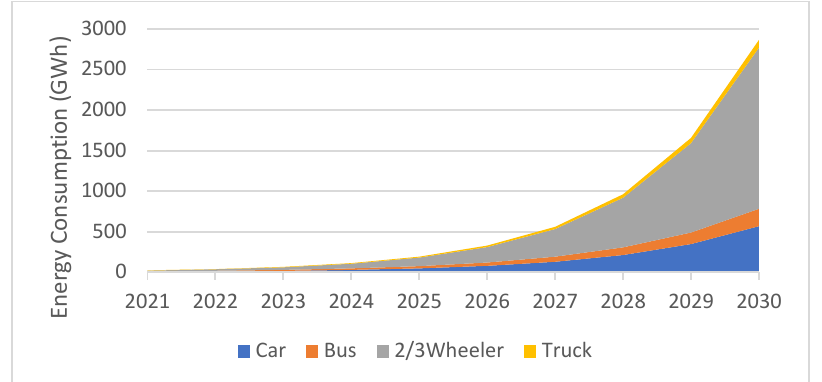
Figure 7. Energy consumption by each EV category.